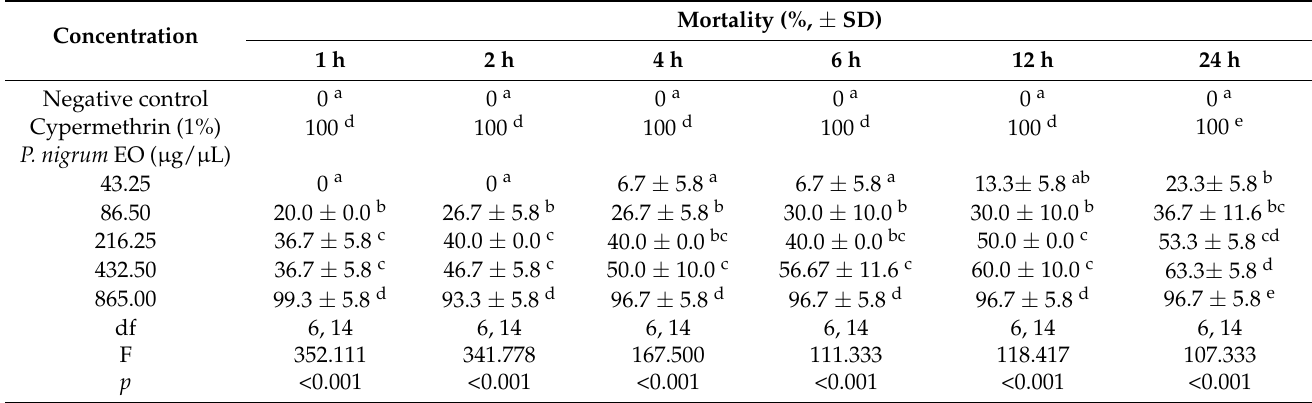
Figure 1. Gas chromatography–mass spectrometry chromatogram of Piper nigrum L. essential oil. The major peaks were α -pinene, sabinene, limonene, and β -caryophyllene, respectively. Table 2. Insecticidal activity of Piper nigrum L. essential oil against Stomoxys calcitrans by contact toxicity testing.